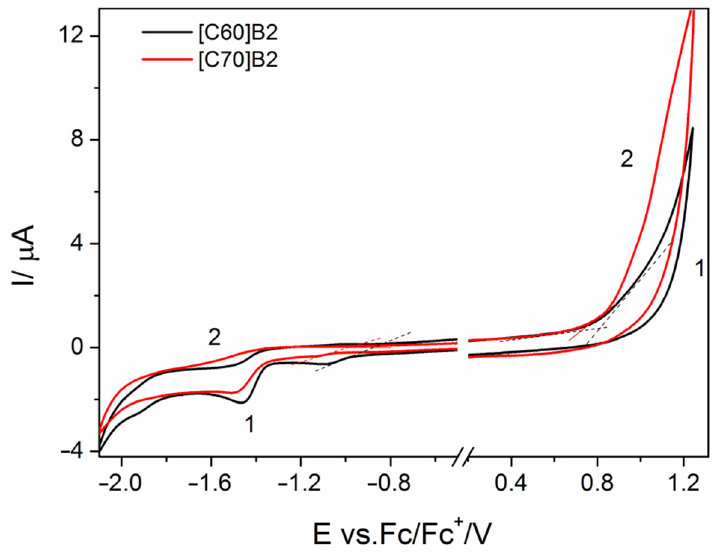
Figure 2. Cyclic voltammograms on Pt electrode in the solutions of [C60]B2 (1) and [C70]B2 (2) in CH 2 Cl 2 containing 0.1 M TBAPF 6 supporting electrolyte.